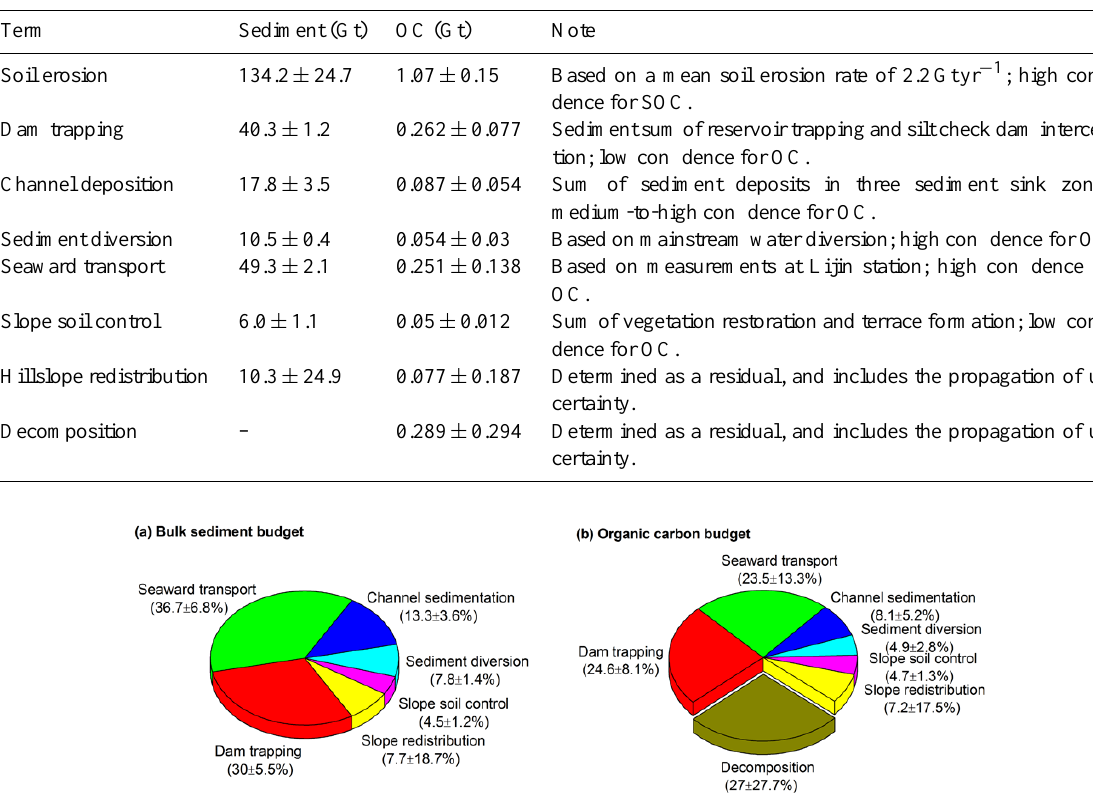
Table 4. Redistribution of the eroded soils and organic carbon in the Yellow River basin during the period 1950–2010.